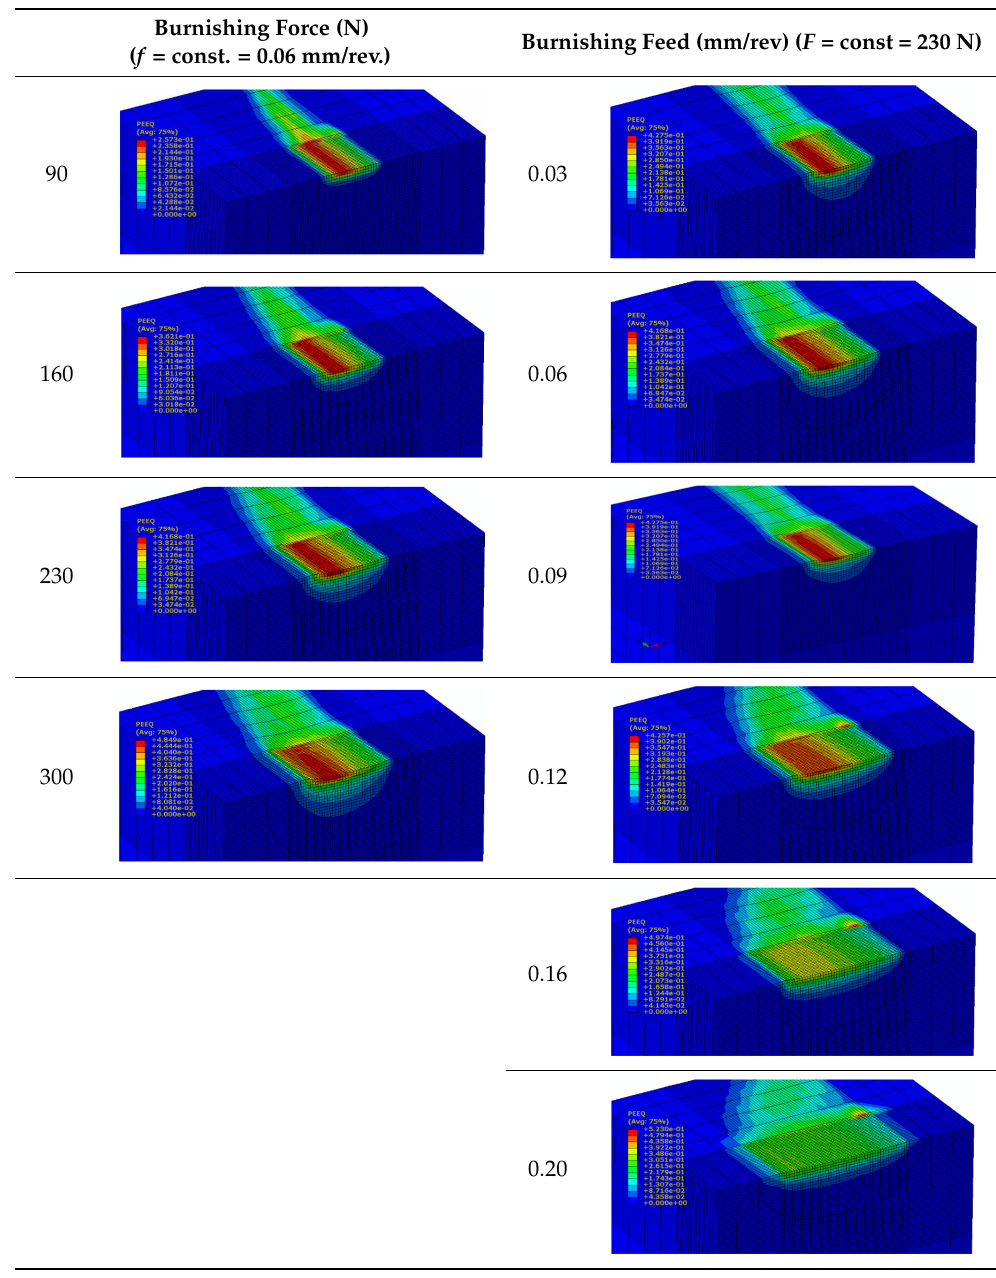
Table 3. Influence of burnishing force and feed on equivalent plastic